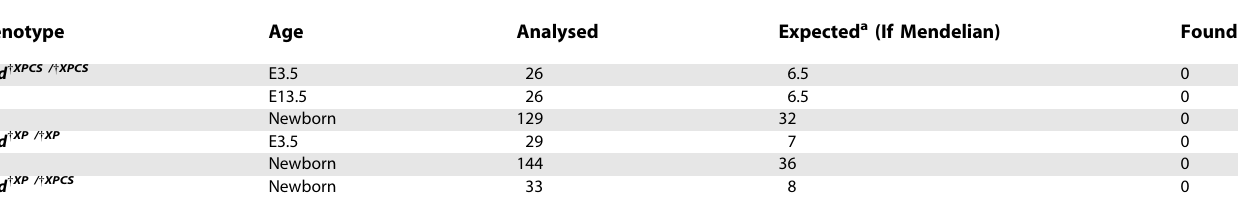
Table 1. Frequency of Xpd (cid:1) XP/ (cid:1) XP, Xpd (cid:1) XPCS/ (cid:1) XPCS, and Compound Heterozygous Xpd (cid:1) XP/ (cid:1) XPCS Embryos and Offspring Genotype